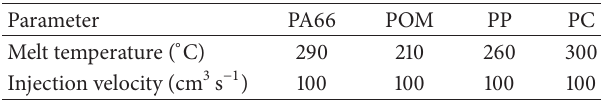
Table 2: Processing parameters